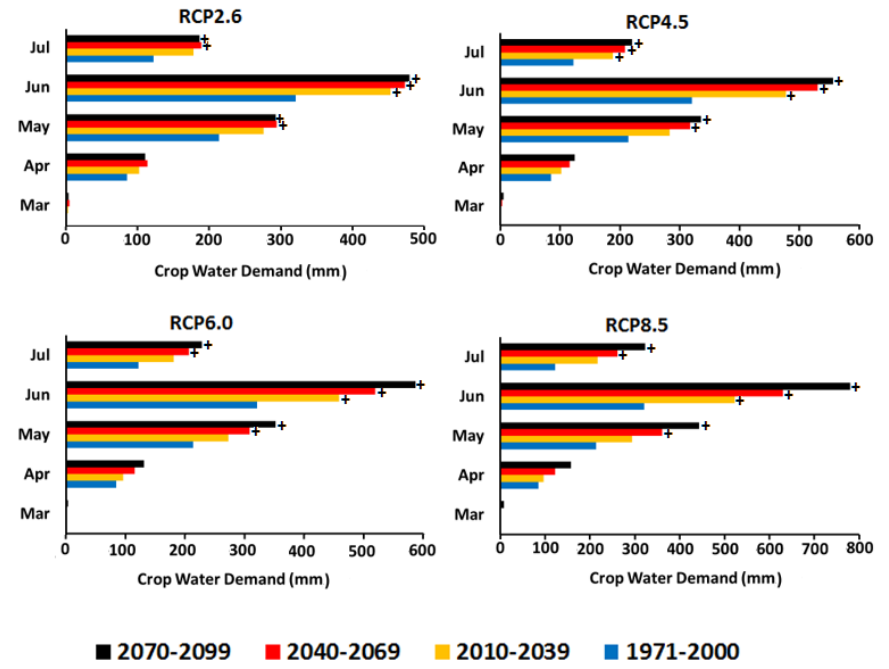
Figure 11. Millet CWD in the different months of the crop season during 2010–2039 (yellow), 2040– 2069 (red), and 2070–2099 (black) and the base year 1961–1990 (blue) and (+) indicates significant change at p < 0.05.